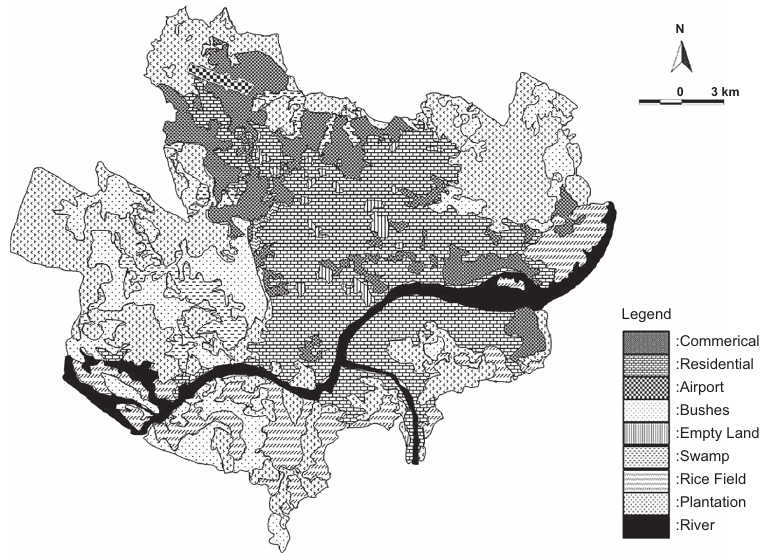
Figure 2. The development land usage map in Palembang city